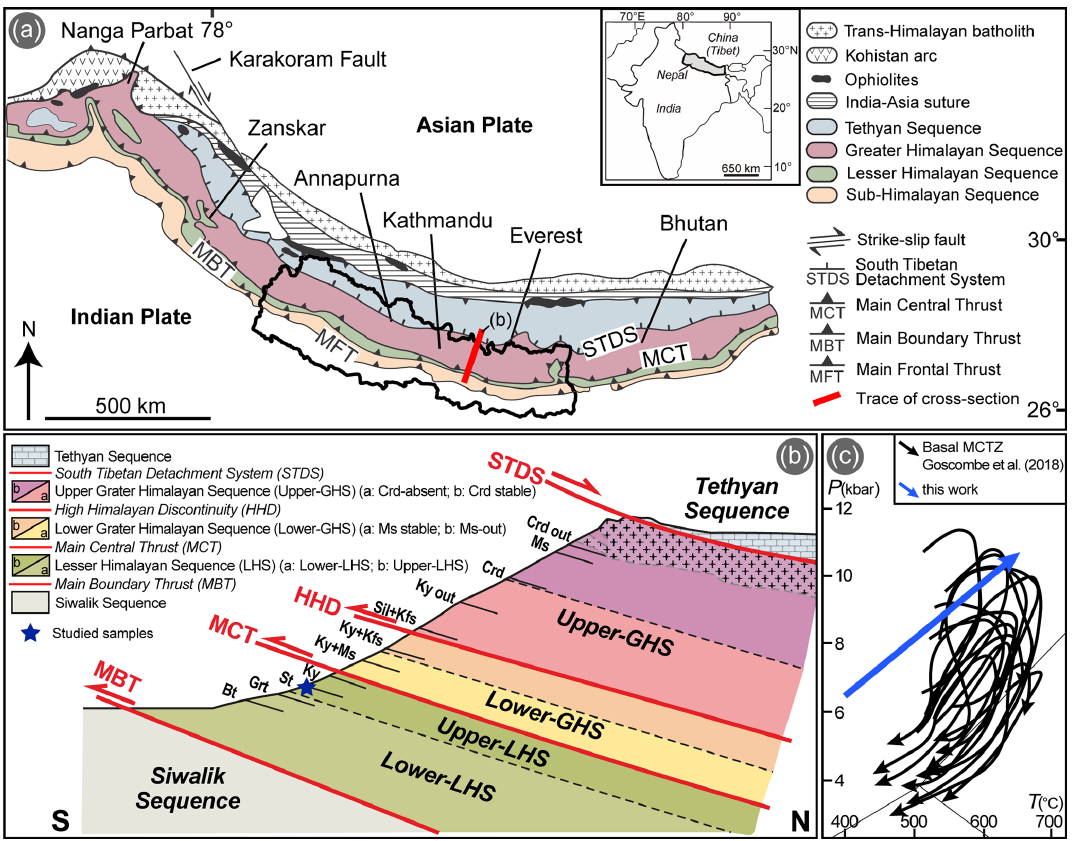
Figure 1. (a) Geological sketch map of the Himalayan belt (modified after Yakymchuk and Godin, 2012), with its geographic location. Nepal boundaries have been highlighted. (b) Not-to-scale NE–SW simplified geological cross section across the Himalayan belt highlighting the internal subdivisions of the LHS and GHS, as well as the presence of index minerals indicating the inverse metamorphic gradient. (c) P – T paths for the basal MCTZ (modified from Goscombe et al., 2018), characterized by amphibolite-facies prograde metamorphism. The blue arrow represents the thermobaric gradient used in this work for the calculation of P / T – X phase diagrams.